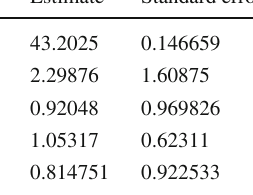
black ones our generated mock data. Bottom left panel: comparison of the D A ( z ) function derived from Eq. (12) (solid red) with that corre- sponding to the Planck Λ CDM (dashed blue) case described in the text. Gray dots and bars are angular diameter distances values and related errors from BOSS and SDSS and black ones our generated mock data. Bottomrightpanel:relativeresidualsbetweenourmodelandthe Planck Λ CDM for the Hubble function (dashed blue), the distance modulus (solid black) and the angular diameter distance (dotted